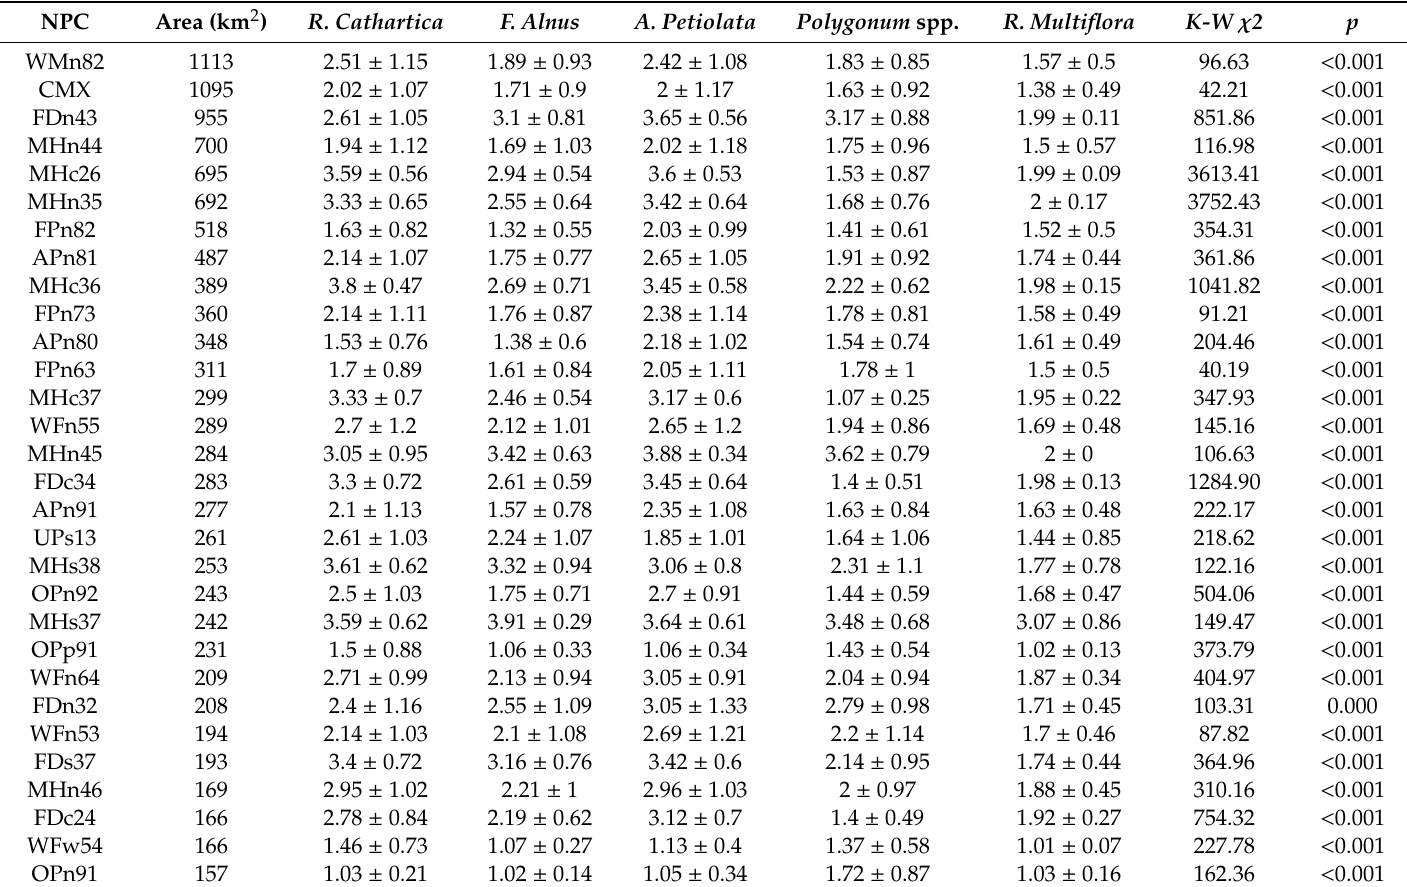
Table 5. Distribution of priority classes for each species across the 30 Minnesota Native Plant Communities (NPCs) with the largest areas. Priority classes correspond to very low = 1, low = 2, medium = 3, and high = 4. Values ± 1 standard